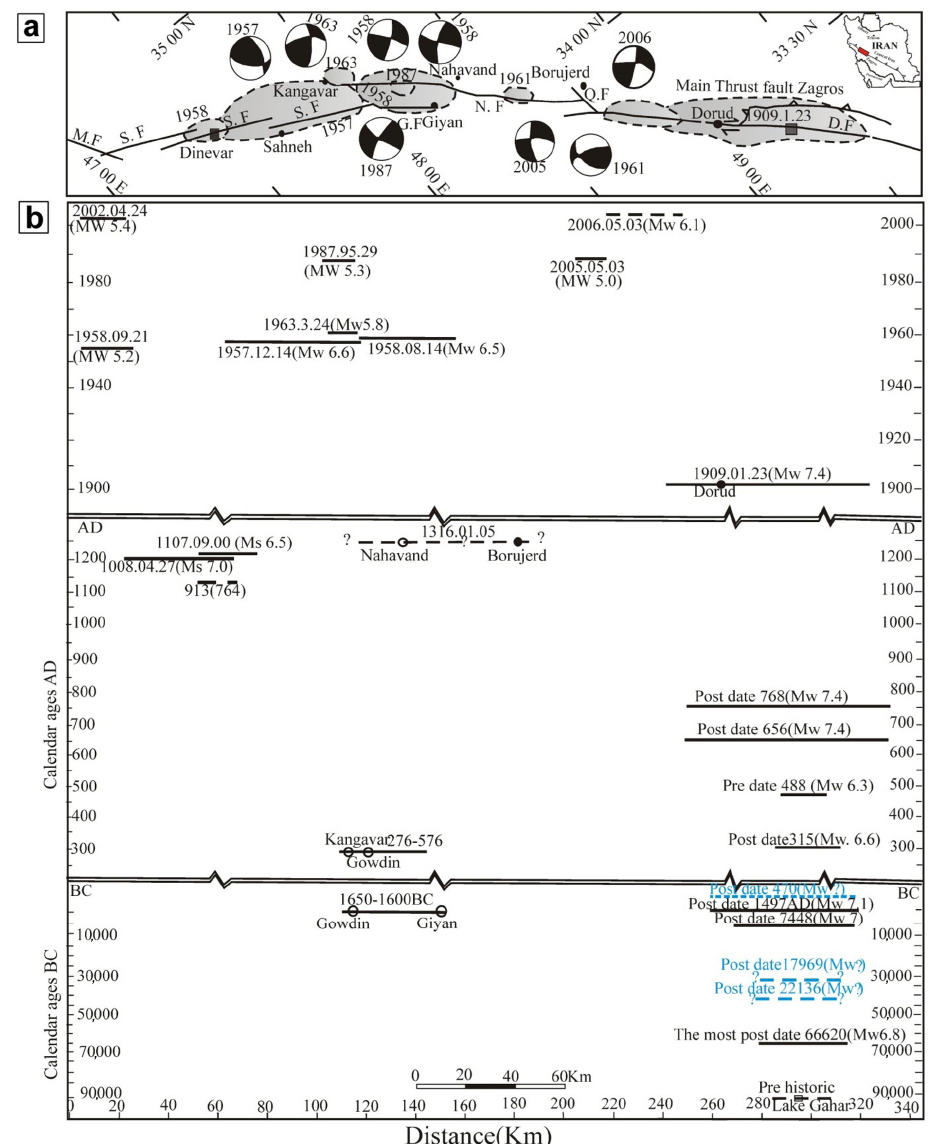
Figure 18. ( a ) Meizoseismal areas of medium to large earthquakes along the Zagros Main Recent Fault. ( b ) Time–space diagram of the earthquakes along the Zagros Main Recent Fault. The 1957 and 1958 focal mechanisms are after [72]; the 1963 solution is after [73] with waveform modeling, which represents a centroid depth from 8 km; 1987 is the CMT solution from Harvard; the 2006 earthquake with a centroid depth of 6 km is from [49]. The early fault plane solutions were based on the in-print short-period polarities, and it is not probable to evaluate the consistency of these early solutions. The figure is modified after [19].